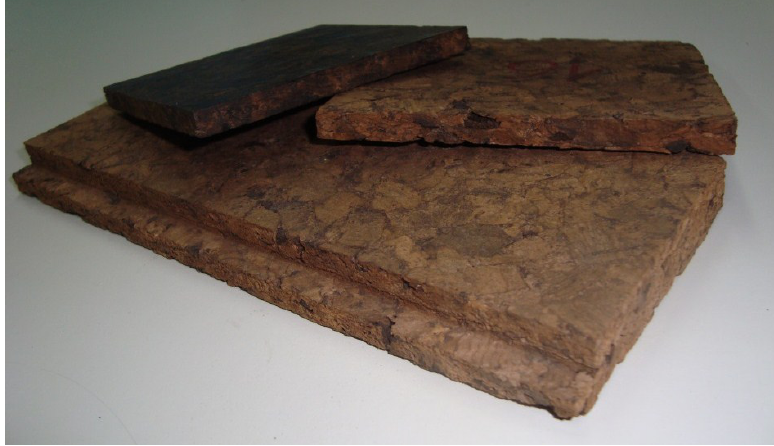
Figure 1. Samples of different densified insulation corkboard (ICB)